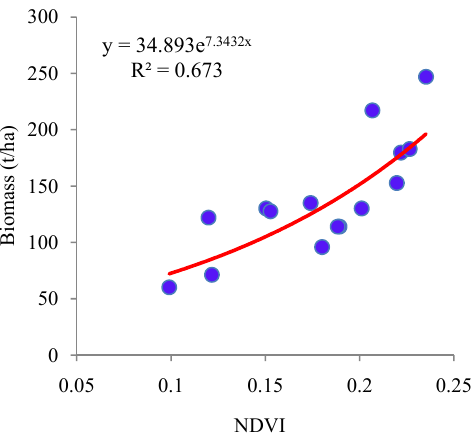
y = 34.893e 7.3432x